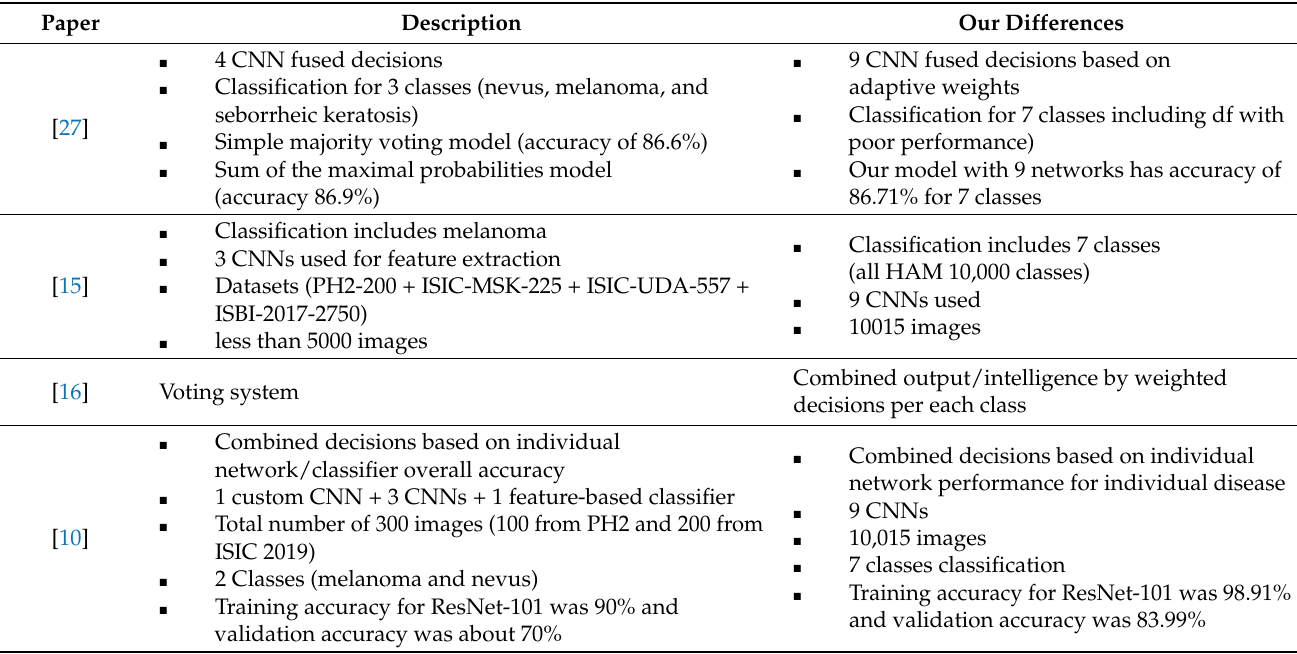
Table 7. A synthetic comparison with the results in similar